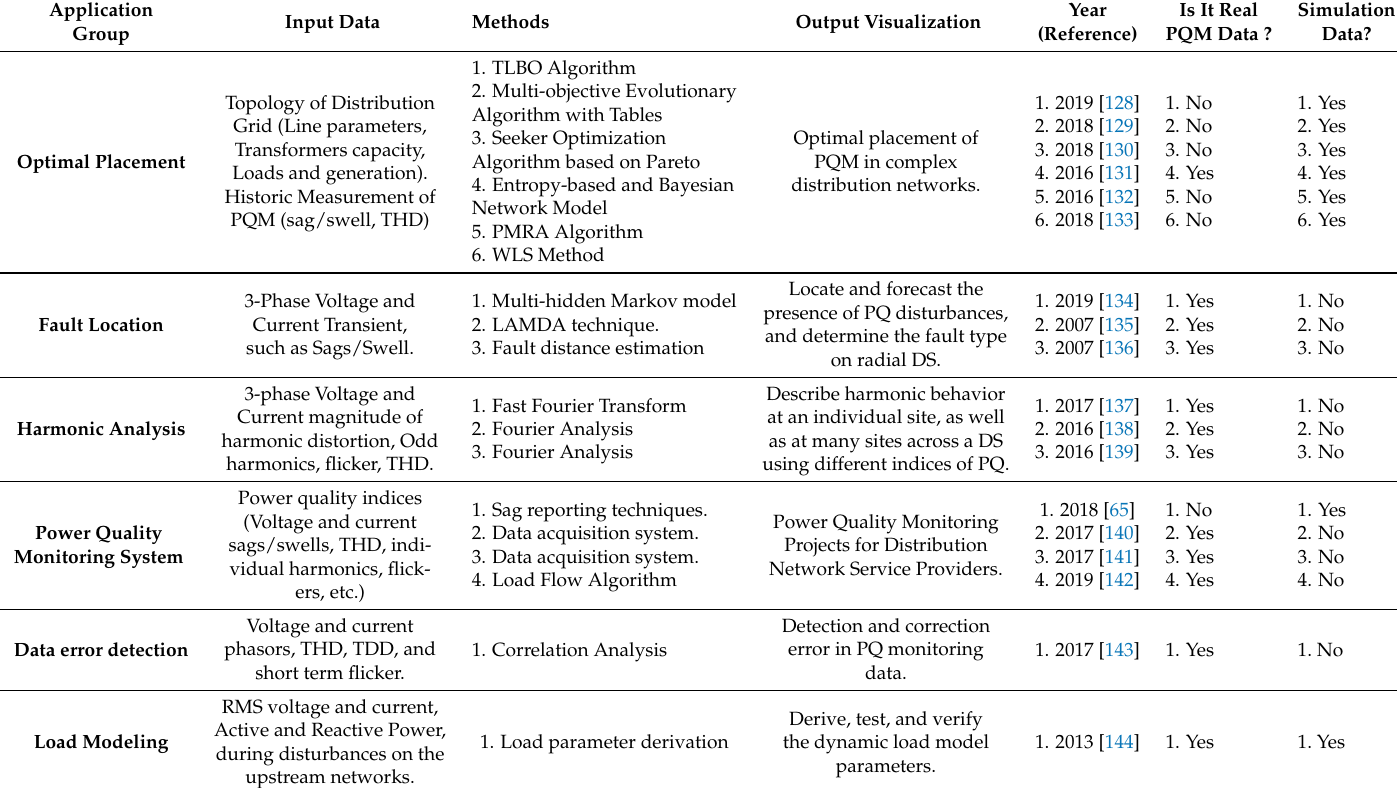
Table 6. Application groups of Power Quality Monitoring